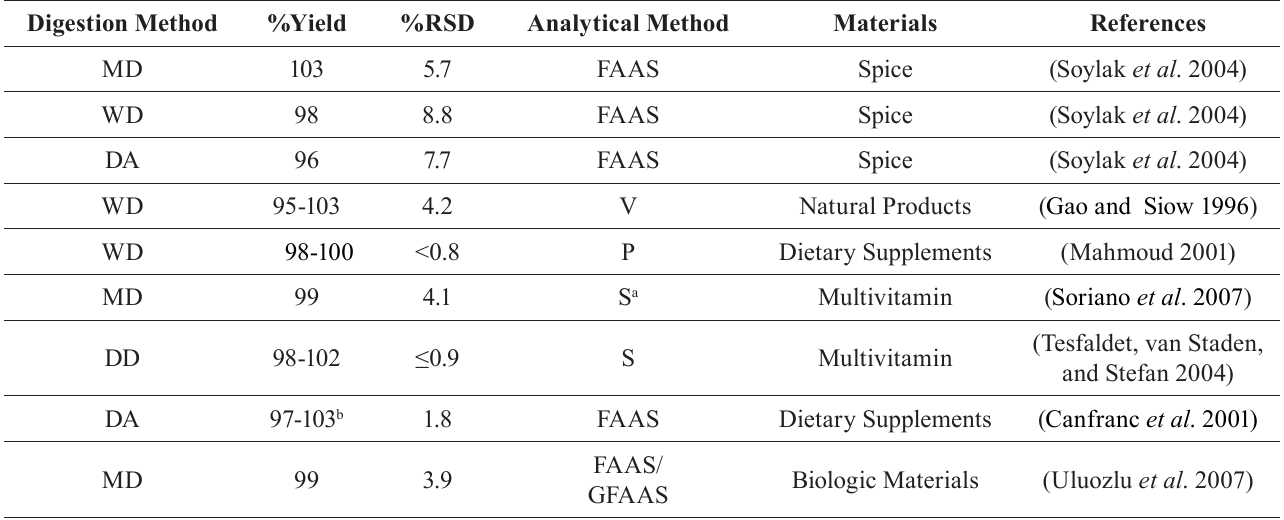
TABLE I - C ompilation of the results for iron determination from previous studies. Ashing. Digestion Techniques: MD = Microwave Digestion, WD = Wet Digestion, DA = Dry Ashing, DD = Direct Dissolution. Analytical Techniques: FAAS = Flame Atomic Absoprtion, V = Voltammetry, P = Potentiometry, S = Spectrophotometry, GFAAS = Furnace